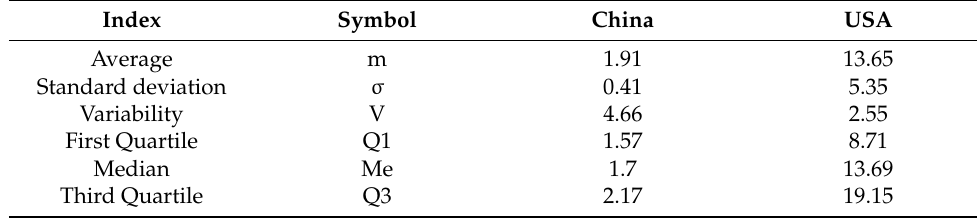
Figure 6. Category Normalized Citation Index (CNCI) for China ( a ) and USA ( b ). Table 5. Statistical characteristics of CNCI indices for China and USA.